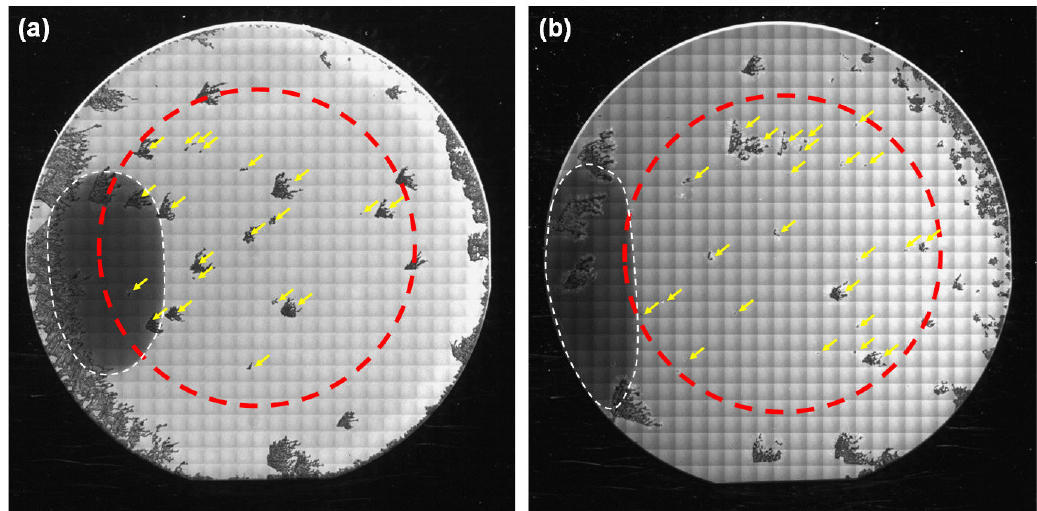
Figure 3. Photoluminescence (PL) images of the on-axis 4H-SiC homoepitaxial layers grown on the 3-inch substrates ( a ) without and ( b ) with HCl flow. ( b ) The HCl flow rate was 810